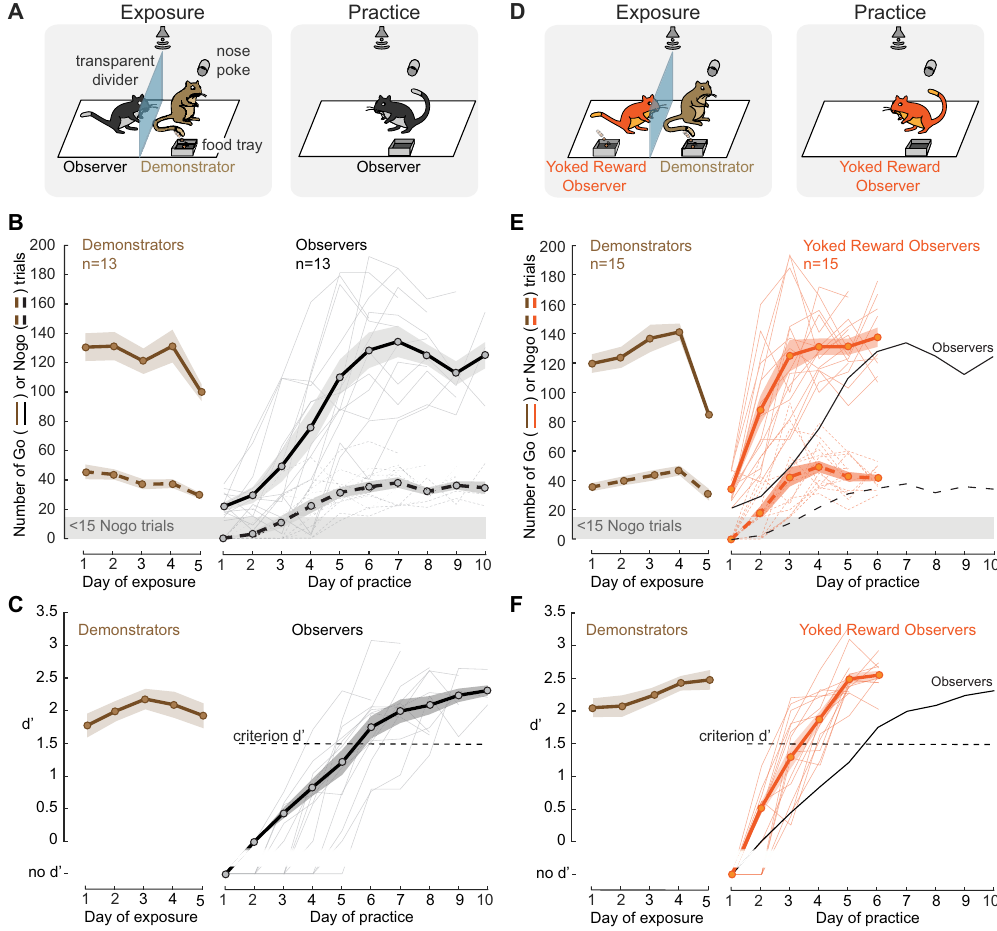
Figure 1. Yoking food reward to an observer facilitates social learning. ( A ) Replication of Fig. 1 from Paraouty et al. 46 . Experimental Design. Left: Naïve observer gerbil (black) was separated from a performing same- sex demonstrator gerbil (brown) by a transparent divider. The demonstrator was previously trained by the experimenters (see “Methods” section for details). Right: Following 5 days of exposure, the practice phase began during which the naïve observer gerbil was permitted to practice the task on its own. ( B ) Mean ± standard error of the mean (SEM) of the number of Go and Nogo trials performed by the demonstrators (5 males; age = 122.6 ± 4.7 days during the 5 days of exposure (brown), and by the naïve observer gerbils (age = 101.4 ± 4.1) during the practice sessions (black). ( C ) Mean ± SEM d ′ values of the demonstrators during the 5 days of exposure (brown) and of the naïve observer gerbils during the practice sessions (black). The performance sensitivity, d ′ was calculated once the observers performed > 15 Nogo trials. ( D ) Experimental Design. Left: Yoked reward observer gerbil (orange) was separated from a performing demonstrator gerbil (brown) by a transparent divider. A food tray was also present in the observer’s compartment, and the food reward of the demonstrator animal was yoked to that of the observer. Right: Practice session, similar to A (right). ( E ) similar to B, with demonstrators (4 males; age = 130 ± 4.2) and yoked reward observers (age = 96.8 ± 5.3). ( F ) Similar to C for the yoked reward observers. For comparison purposes, the observers’ results from 1B and 1C are replicated on Figures ( E ) and ( F ),